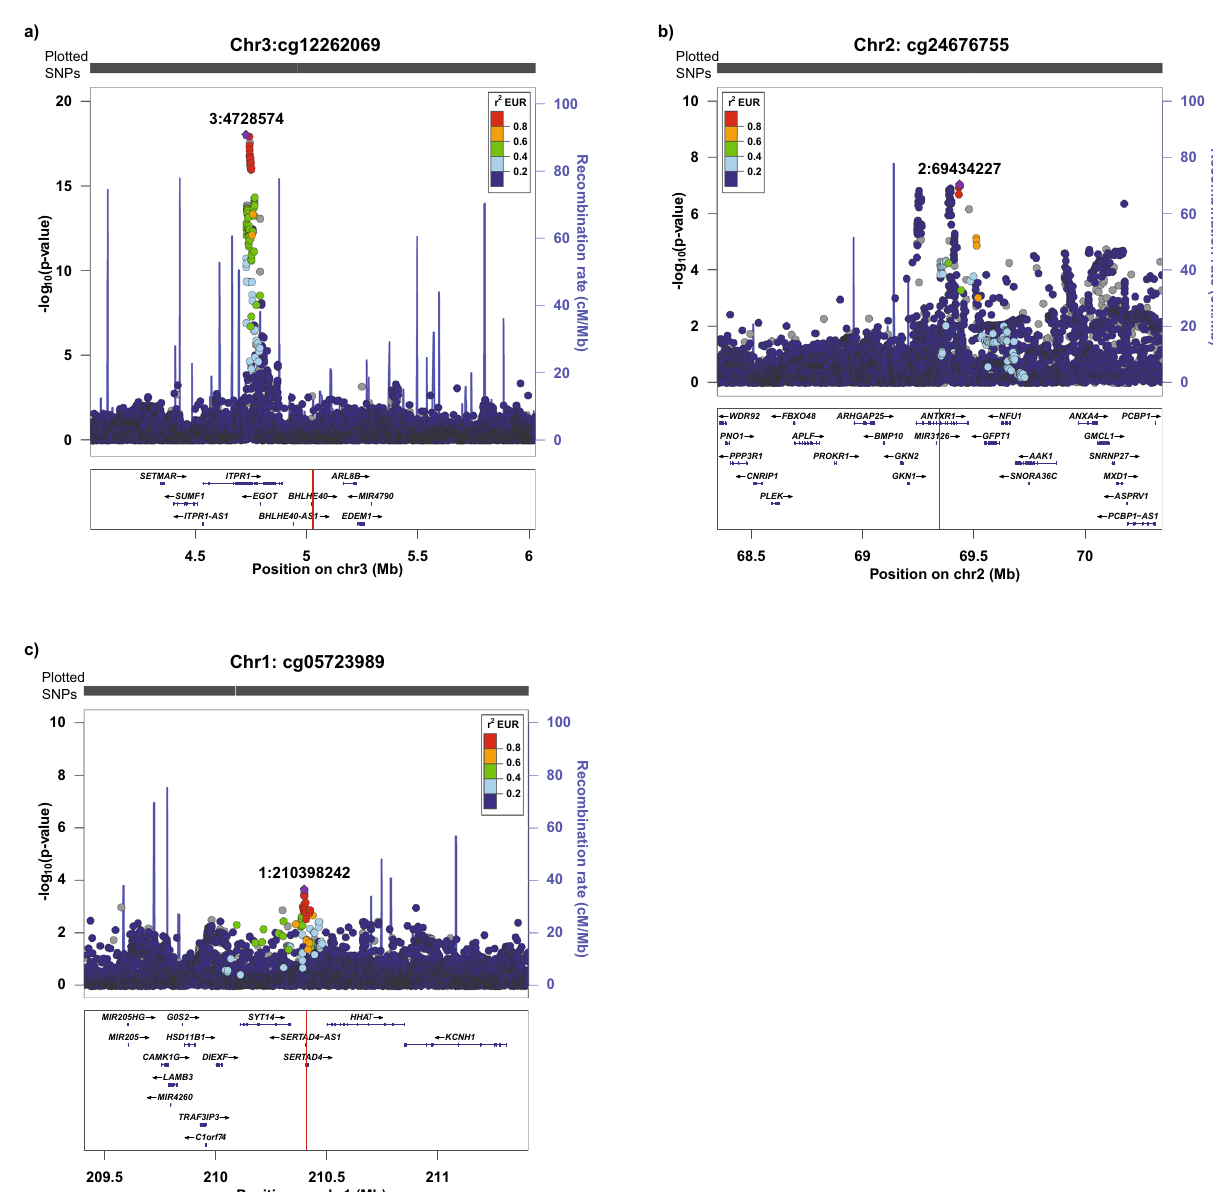
Fig. 3 LocusZoom plots of the ±1 Mb fl anking regions for selected breast cancer (BrCa) CpGs. The red line in the gene panel indicates the genomic location of the CpG site. Panel a is an example of a BrCa CpG with genome-wide signi fi cant SNPs in the fl anking region, panel b is an example of a BrCa CpG with suggestive SNPs in the fl anking region, and panel c is an example of a BrCa CpG identi fi ed in a novel region (i.e., no genome-wide signi fi cant or suggestive SNPs present in the fl anking